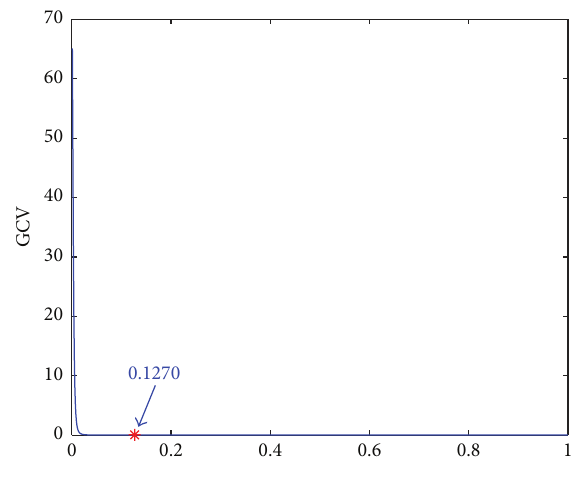
Figure 25: The cantilever beam structure of MIMO system.